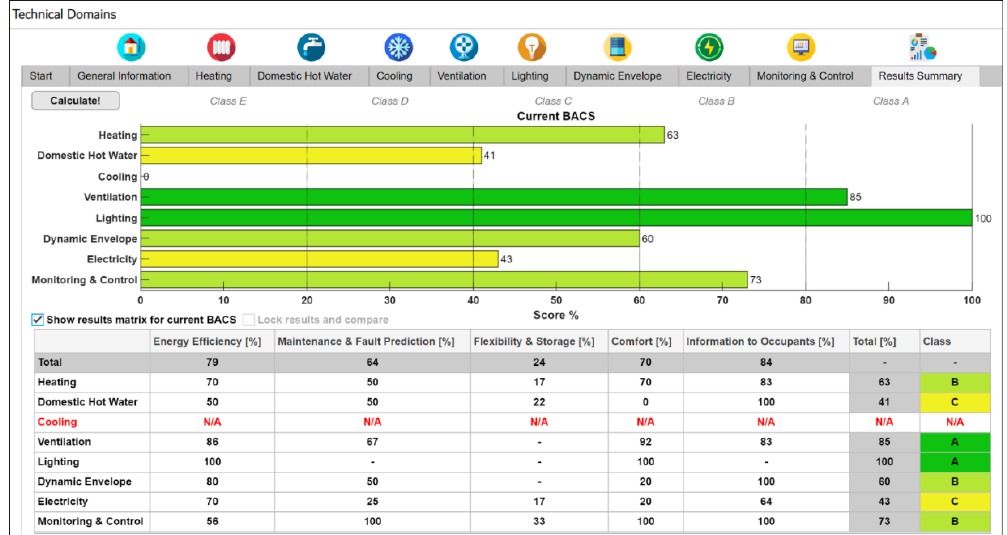
Figure 3. Screenshot of IBACSA ‘Results Summary’.